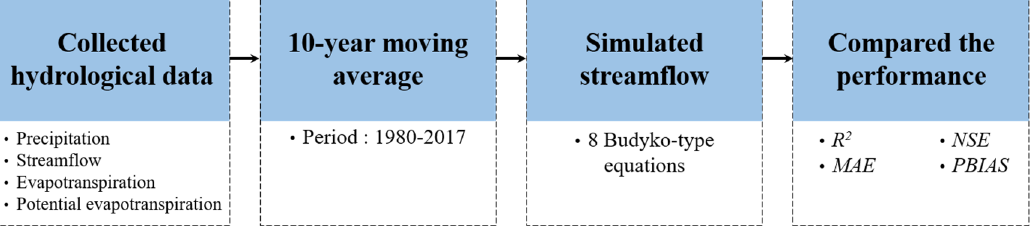
Figure 2. Screening processes of the best fitting Budyko equation in this study. ( R 2 : Coefficient of determination; MAE : Mean Absolute Error; NSE : Nash-Sutcliffe Efficiency coefficient; PBIAS : Percent bias) Table 2. Different equations collected from the previous studies based on the Budyko hypothesis.